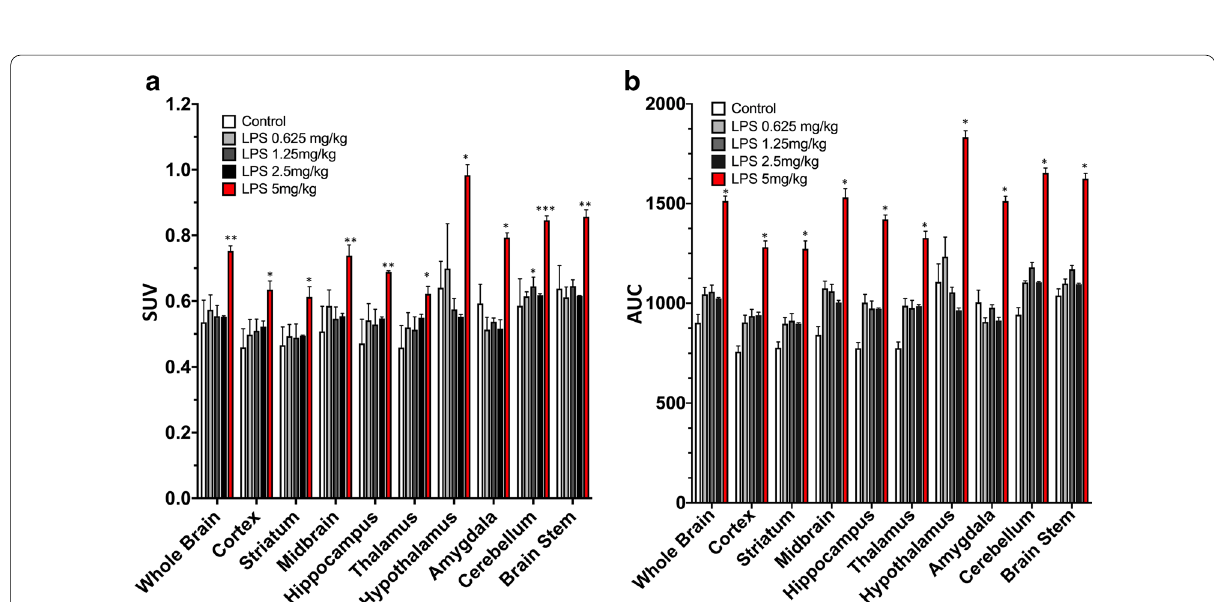
Fig. 7 [ 18 F]FEPPA SUV and AUC for various brain regions in control mice and mice injected with different of doses LPS. Data are mean mice per group; * p < 0.05, ** p < 0.01, ** p < 0.001, one‑way ANOVA with Bonferroni post hoc